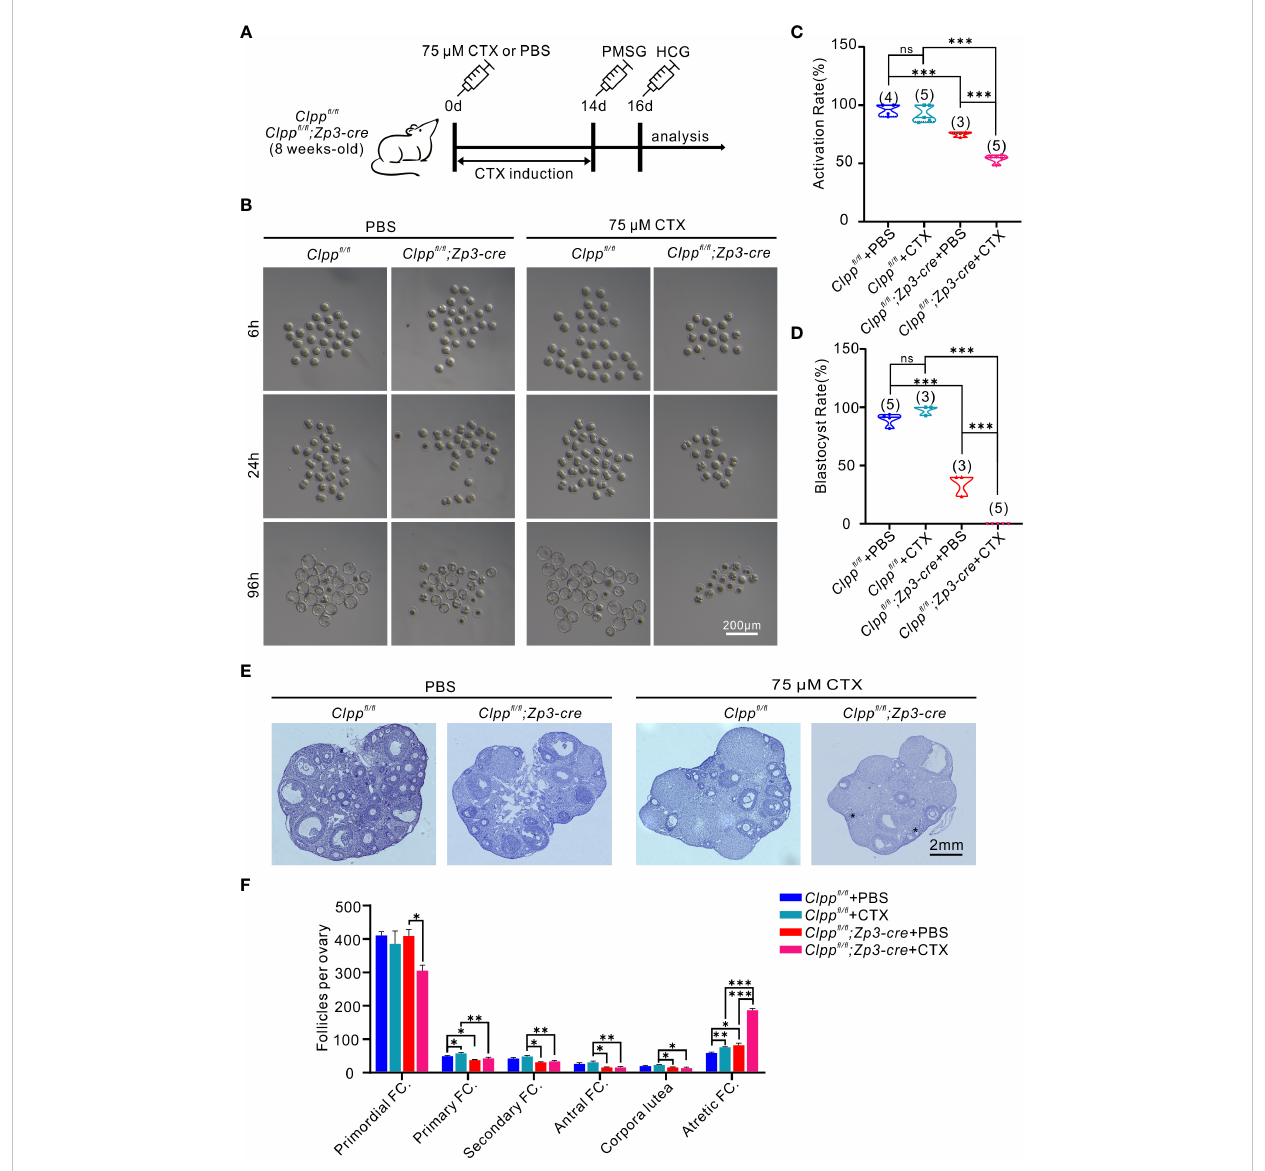
FIGURE 4 CTX deteriorated oocyte competence and follicle development in Clpp fl / fl ; Zp3 -Cre mice. (A) Schematic diagram showing the experimental design of cyclophosphamide injection. 8-week-old mice were injected intraperitoneally with 75 m M cyclophosphamide (CTX) at day 0. After 14 days of feeding on a normal diet, PMSG was injected on day 14 to promote follicle development, and HCG was injected on day 16 to excrete oocytes. (B) Representative images of different stages of MII oocytes after parthenogenetic activation obtained by stereomicroscope. (C) 6h After parthenogenetic activation, 2 pre-nucleolus observed was considered to be successfully activated. (D) The blastocyst rate showed the ratio of the total number of blastocysts and activated oocytes 96 hours after parthenogenetic activation. (E) Histomorphological analysis of mice ovaries after 14 days of cyclophosphamide treatment. (F) Folliculogenesis was compared among four groups. (n=3) All the oocyte and ovary samples were given one injection at 8 weeks of age. Continue feeding for 14 days after injection. N.S. means no signi fi cant difference; * p < 0.05; ** p < 0.01; *** p < 0.001. The results represent mean ± SEM. Signi fi cance was determined by Student t